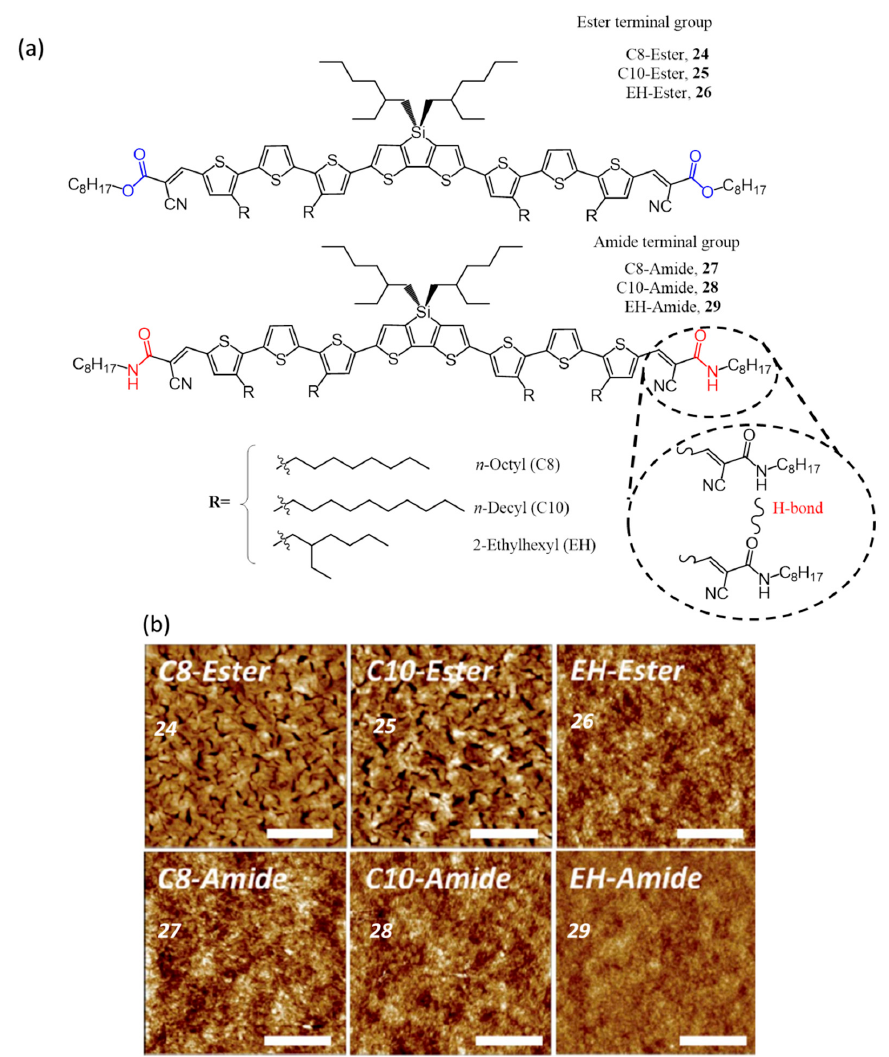
Figure 11. ( a ) Chemical structures of 24 – 29 synthesized by Kim et al. [58]. ( b ) AFM height images of the optimized active layer consisting of small molecule donors and PC 61 BM; the scale bar is 1 μ m.